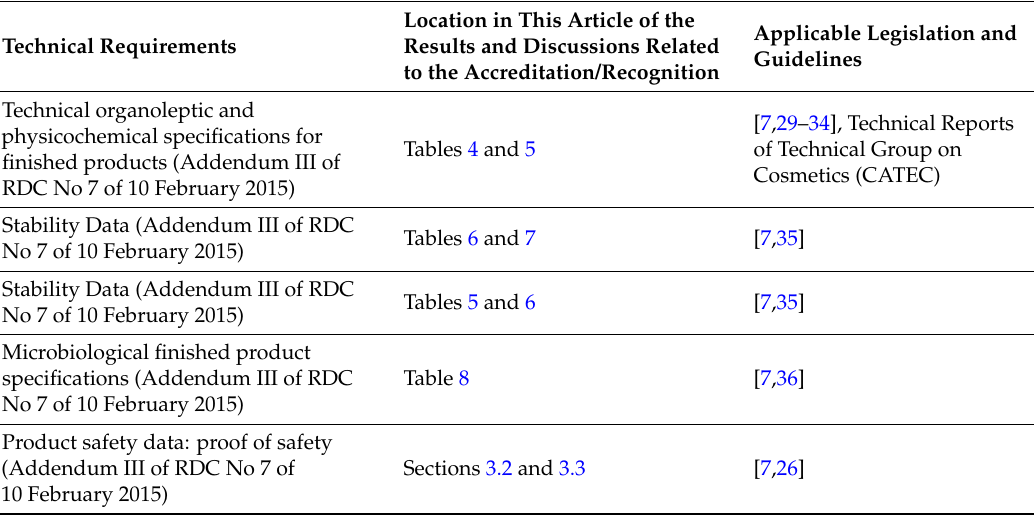
Table 2. Pertinent results of the register and notification phase of a cosmetic